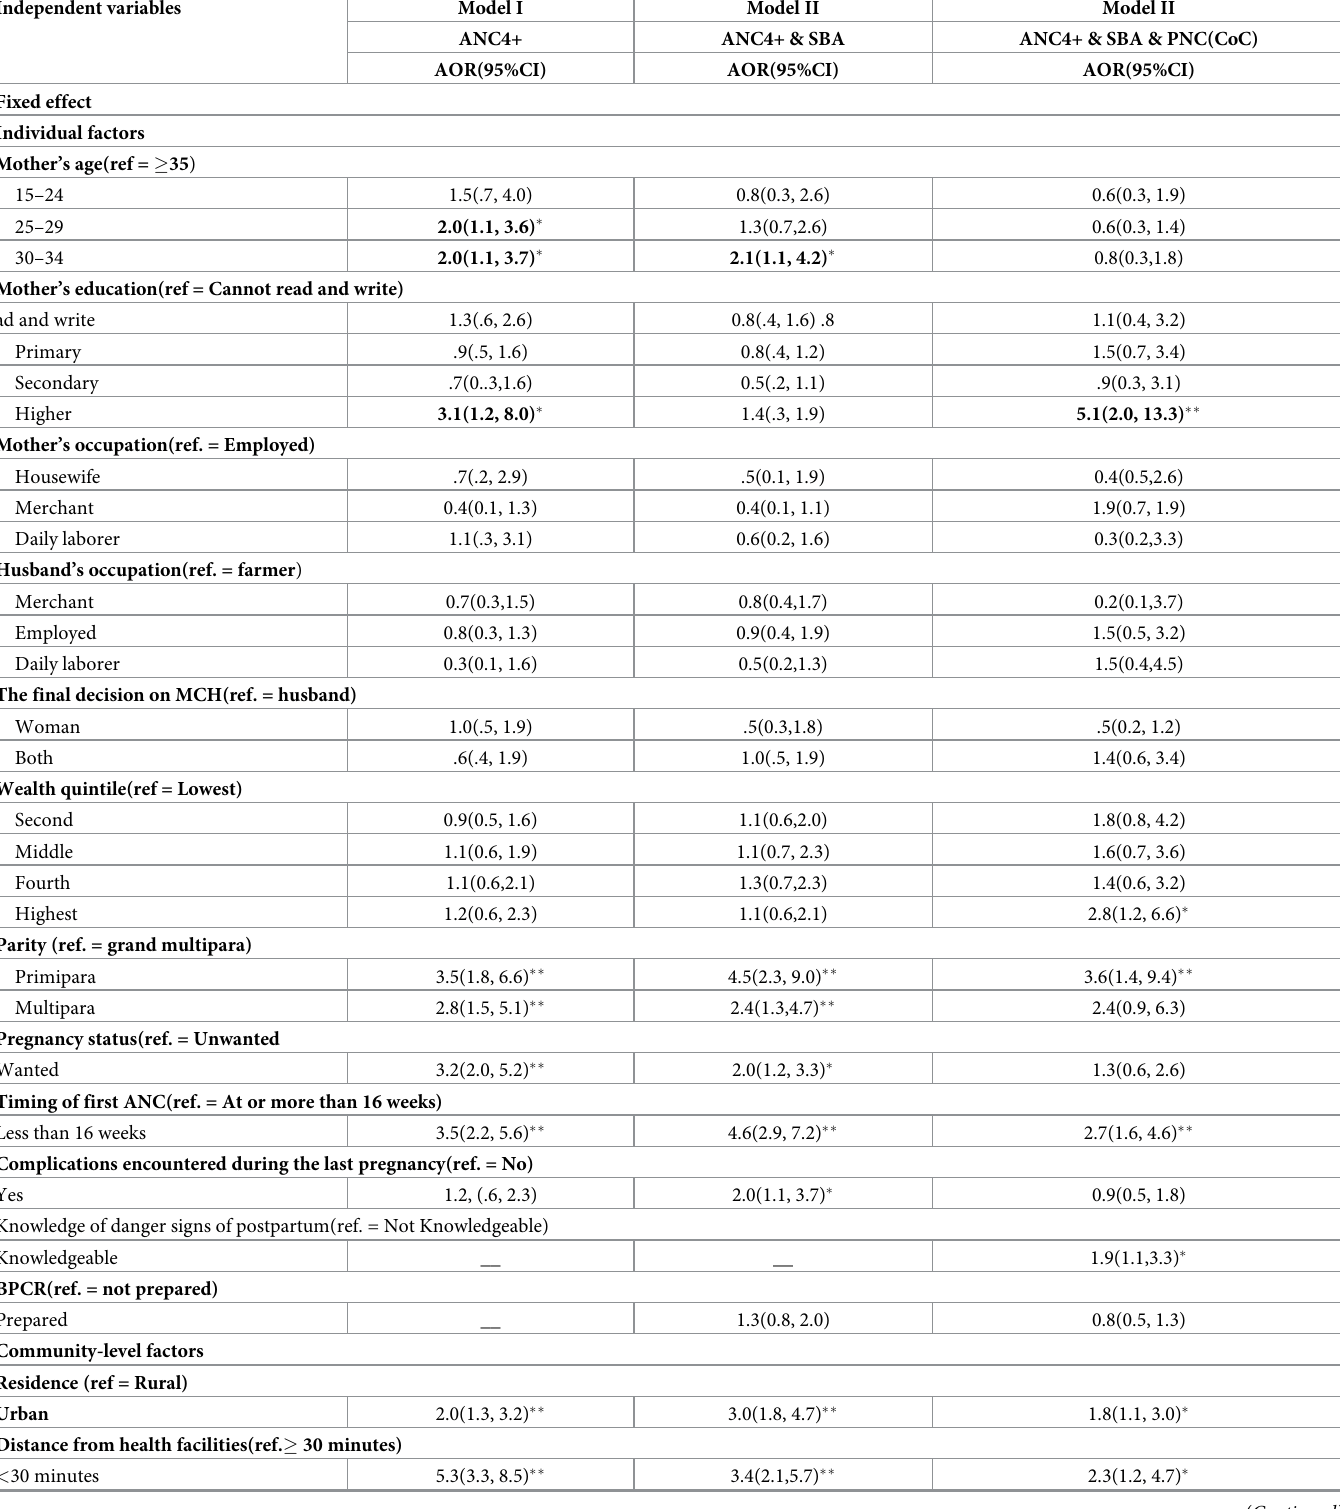
Table 5. Results of multilevel binary logistic regression analysis on the continuum of the maternal care pathway among participants in the Hadiya zone,